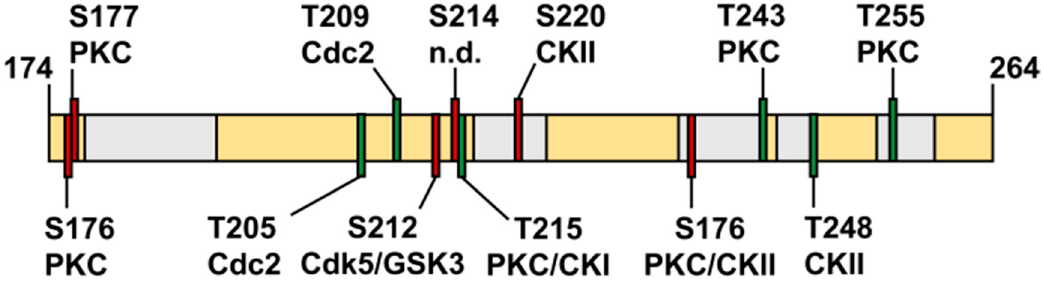
Figure 10. Phosphorylation sites predicted by Netphos-3b1. Schematic drawing of the linker region (residues 174 to 264) in yellow. Putative helices are represented by gray horizontal bars. Predicted phosphorylation sites are depicted as red (serine) and green (threonine) vertical bars. The respective phosphorylated residues and their putative modifying kinases are marked (PKC = protein kinase C; CKI/CKII = casein kinase I/II; Cdc/Cdk = cyclin-dependent kinase; GSK3 = Glycogensynthase kinase 3).